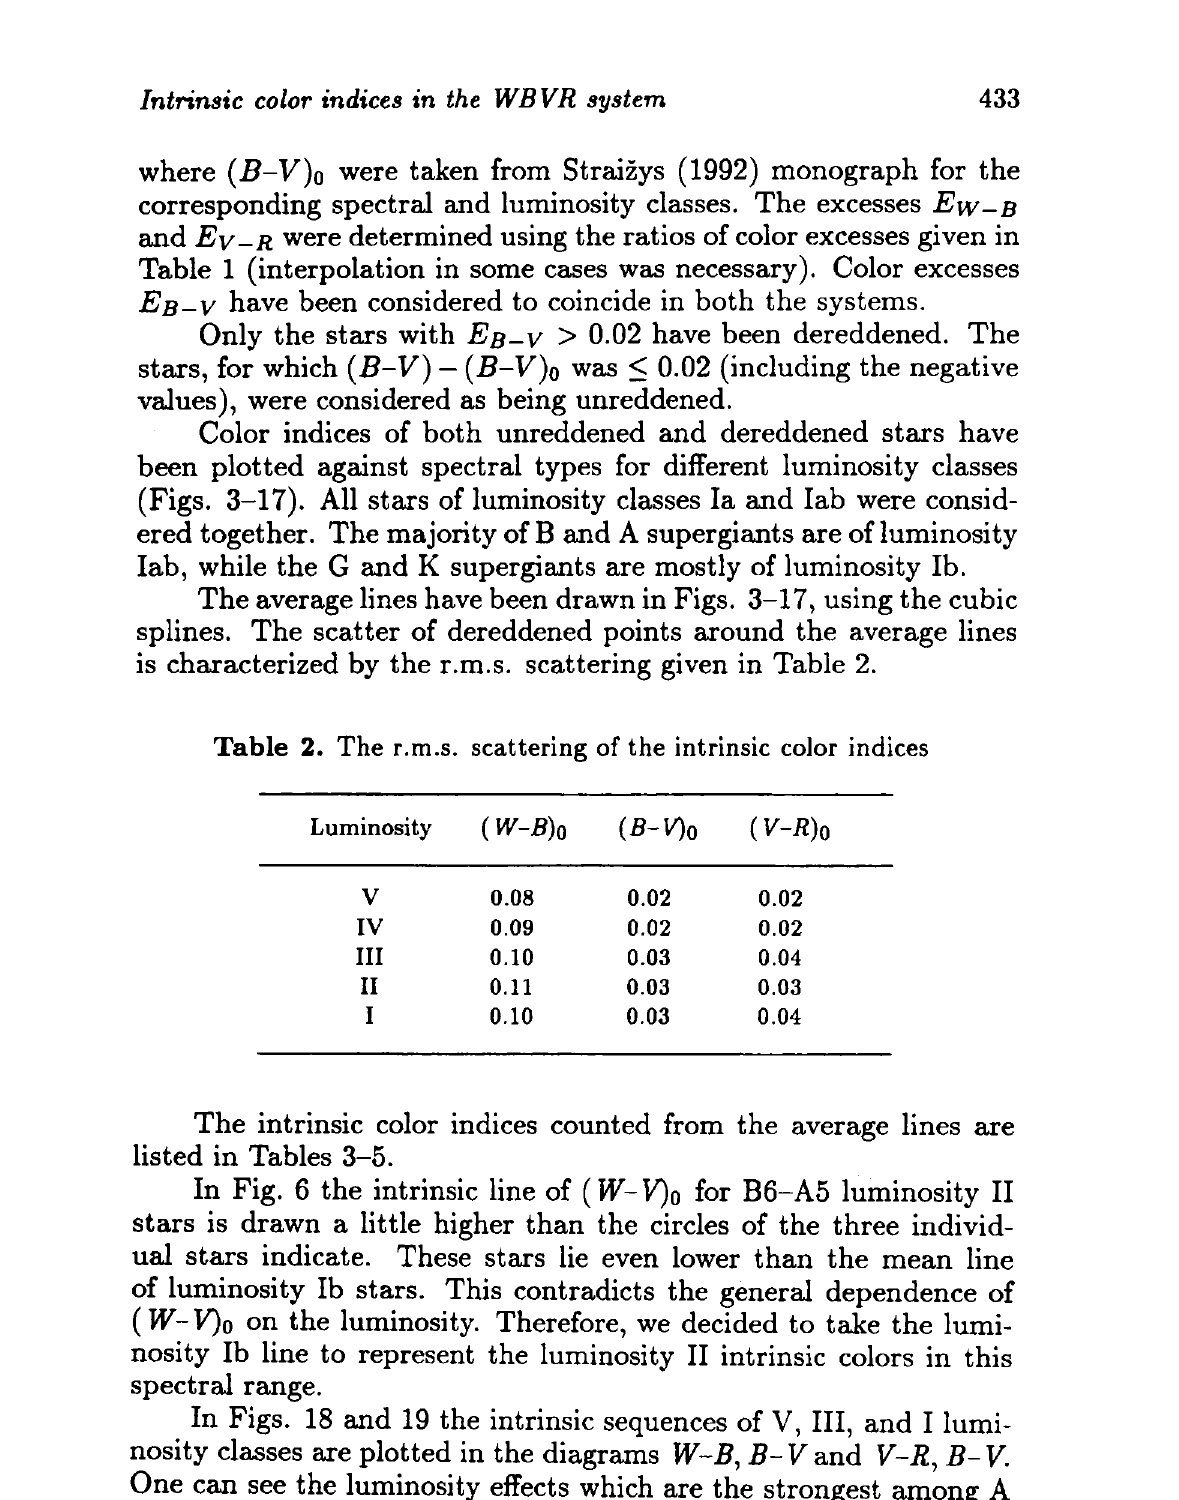
Table 2. The r.m.s. scattering of the intrinsic color indices